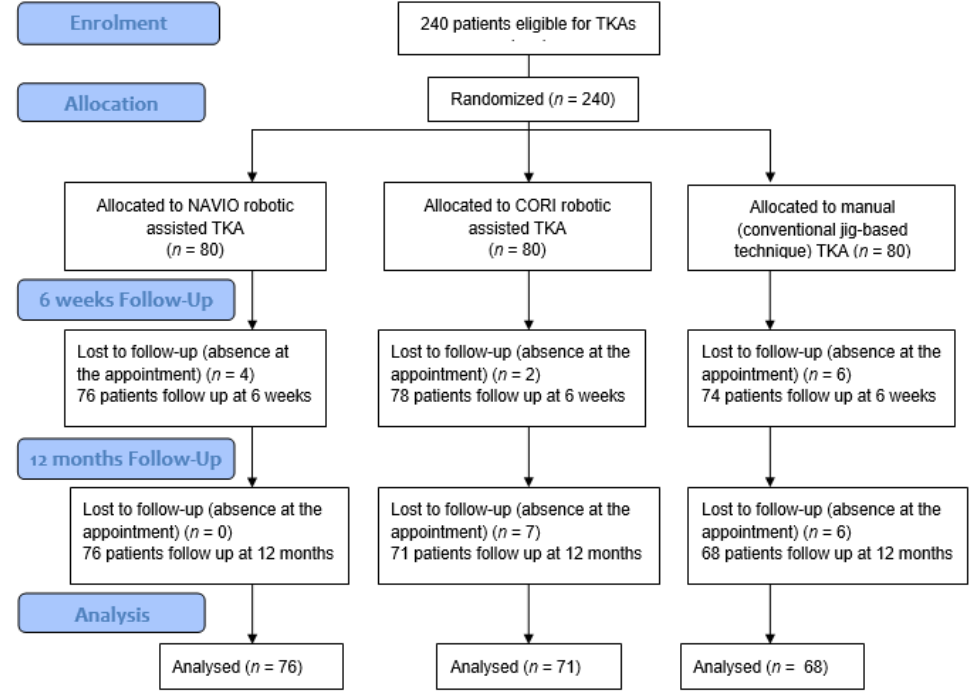
Figure 1. Flowchart of the randomized controlled trial KOOS, ROM in extension, VAS in TKA with the use of ra-TKA and mTKA.